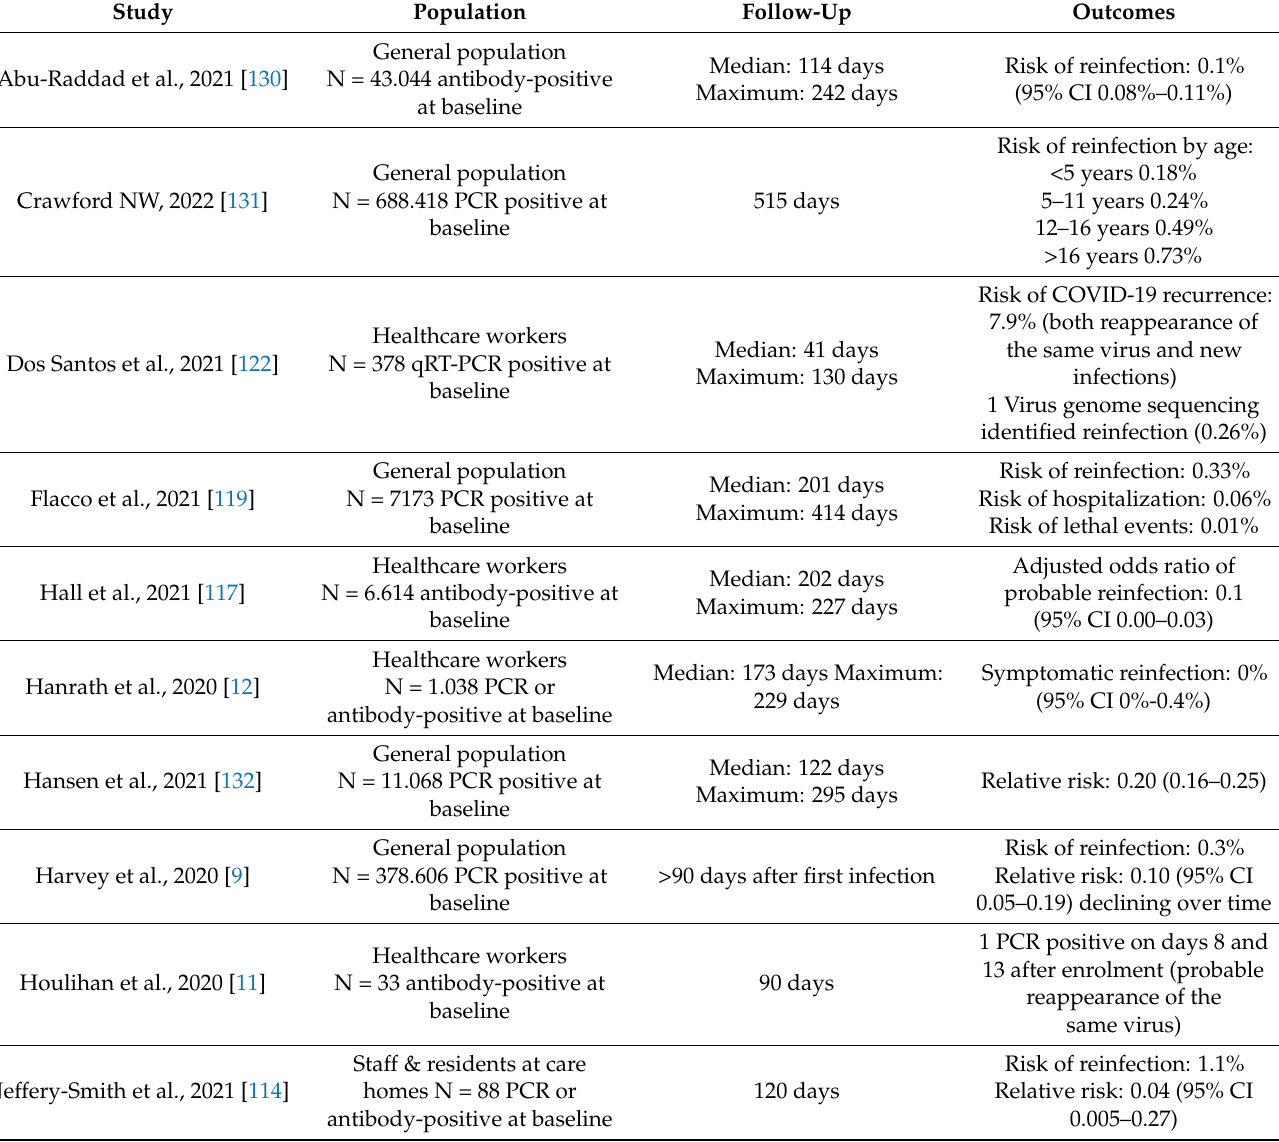
Table 1. Summary of included studies and primary outcomes results about the risk of